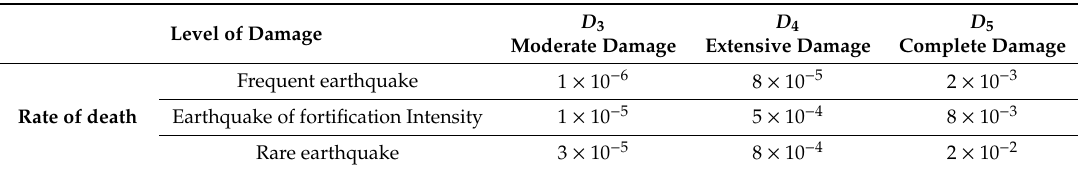
Table 9. The predicted rates of death in buildings with di ff erent levels of damage under three earthquake